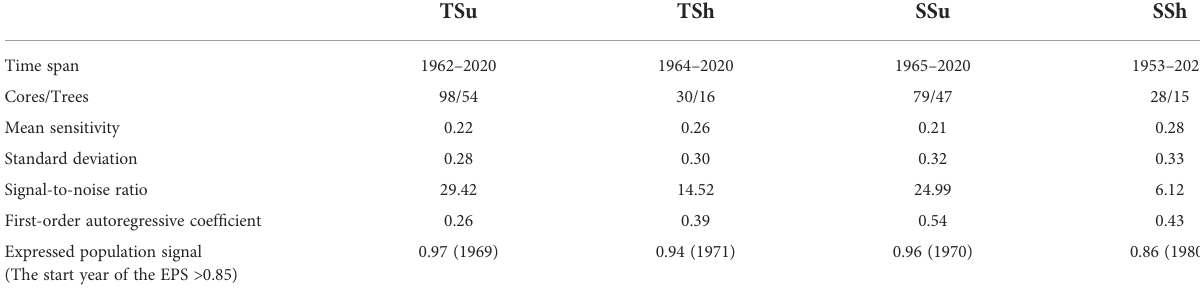
TABLE 1 Standard chronology (STD) statistics for all plots.